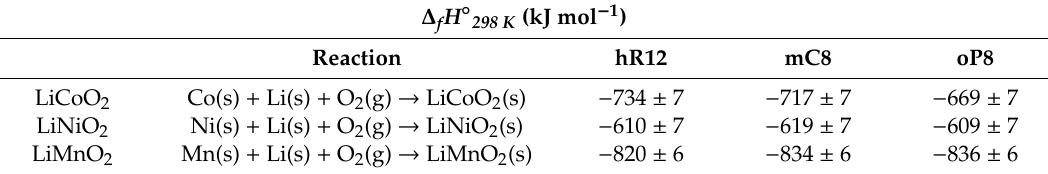
Table 4. Calculated Gibbs Energy of formations at 0 K from elements for all the polymorphs (hR12, mC8 and O) of the LCO, LMO and LNO compounds. Errors have been estimated by propagating the accuracy of the thermochemical supporting data. Energy evaluations involving experimentally reported phases are in bold.